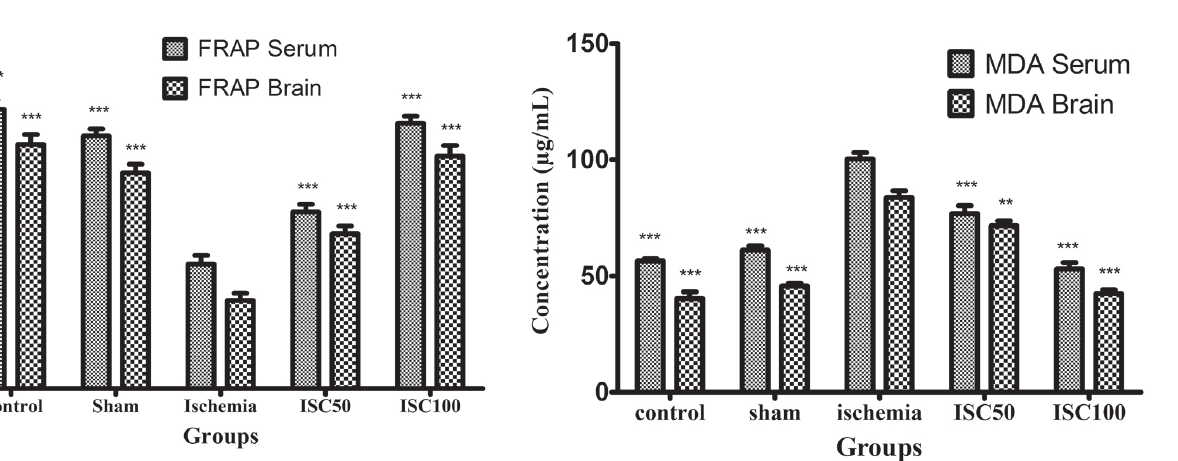
FIGURE 4 - The effect of A. italica extract on MDA of serum and brain on hippocampal injury induced by transient global cerebral ischemia and reperfusion. ISC 100 and ISC 50: treated with 100 and 50 mg/kg of A. italica extract, respectively. (*** and **: significant difference between the all groups with ischemia group, P<0.001, P<0.01). The number of samples,